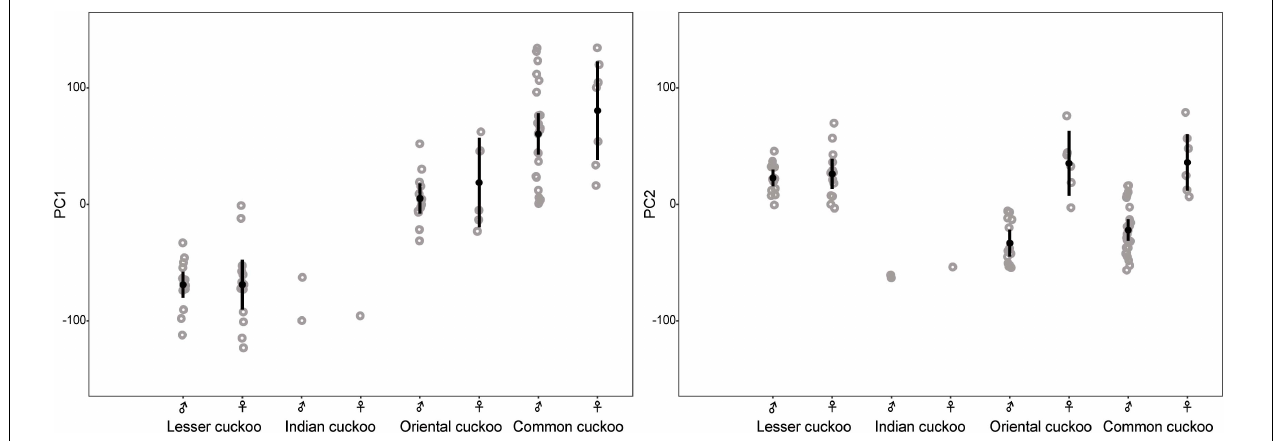
FIGURE 7 | Comparison of the PC1 and PC2 among the four Cuculus cuckoos. Each dot indicates the value of PC1 and PC2. Black dots with vertical bars indicate mean values with its 95% confidence intervals.